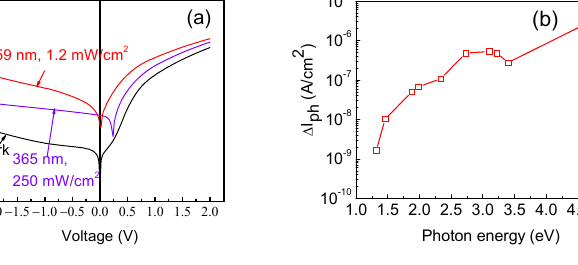
Figure 9. ( a ) I-V characteristic in the dark, with 365 nm LED illumination, and 259 nm LED illumination; ( b ) reverse photocurrent spectrum at − 1 V; ( c ) forward photocurrent spectrum at 2 V. The capacitance versus frequency C-f dependencies at room temperature, 420 K, and